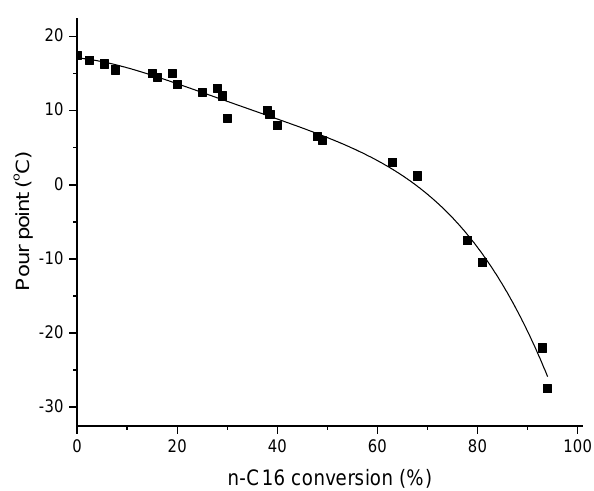
Figure 1. Pour point as a function of hexadecane conversion: Conditions: temperature range of 260–320 °C and 50–100 bar, respectively using weight hourly space velocity (WHSV) of 1.1–2.8 hr −1 adapted from [10]. Reproduced with permission from Gomes et al., Fuel ; published by Elsevier, 2017 .